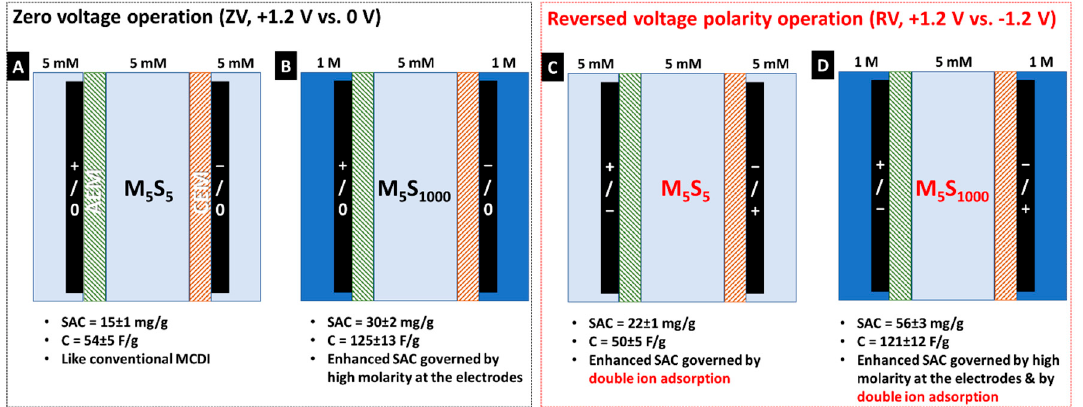
Figure 6. Desalination performance of multichannel membrane CDI (MC-MCDI) with a concentration-gradient operation between the middle and the side channels under zero voltage operation (ZV, + 1.2 V vs. 0 V) ( A , B ) and reverse voltage operation (RV, + 1.2 V vs. − 1.2 V) ( C , D ). The M 5 S 5 and M 5 S 1,000 indicate the concentration of the middle (5 mM NaCl) and side channel (5 mM NaCl or 1000 mM NaCl) (Reprinted with permission from Reference [15]).